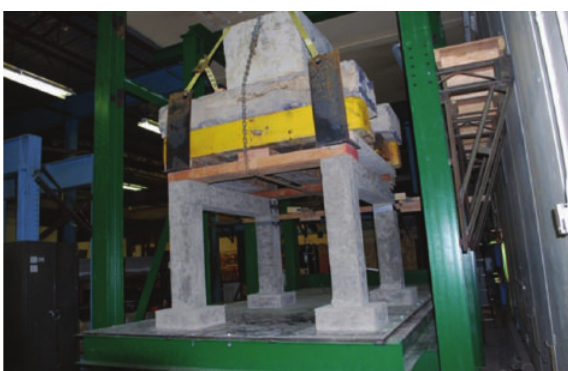
Figure 2: Experimental setup of the model on the shake table.